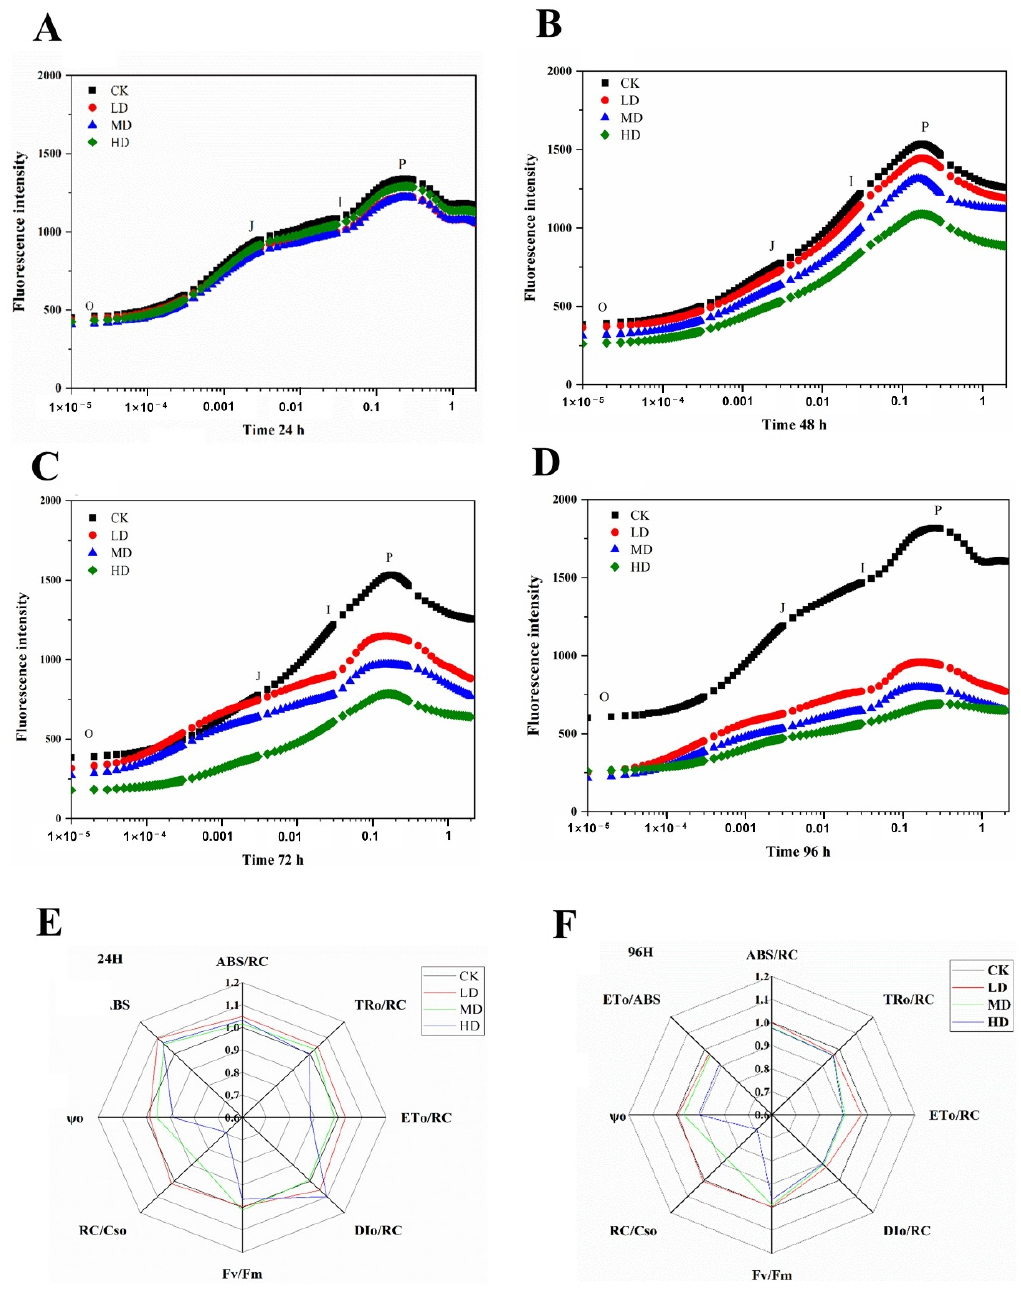
Figure 3. Effects of 17 α -EE 2 concentrations on the chlorophyll a fluorescence transients ( A – D ) of C. pyrenoidosa within 96 h exposure and chlorophyll fluorescence parameter radar diagram at 24 h, 96 h ( E , F ). CK: control; LD: low dose; MD: moderate dose; HD: higher dose.